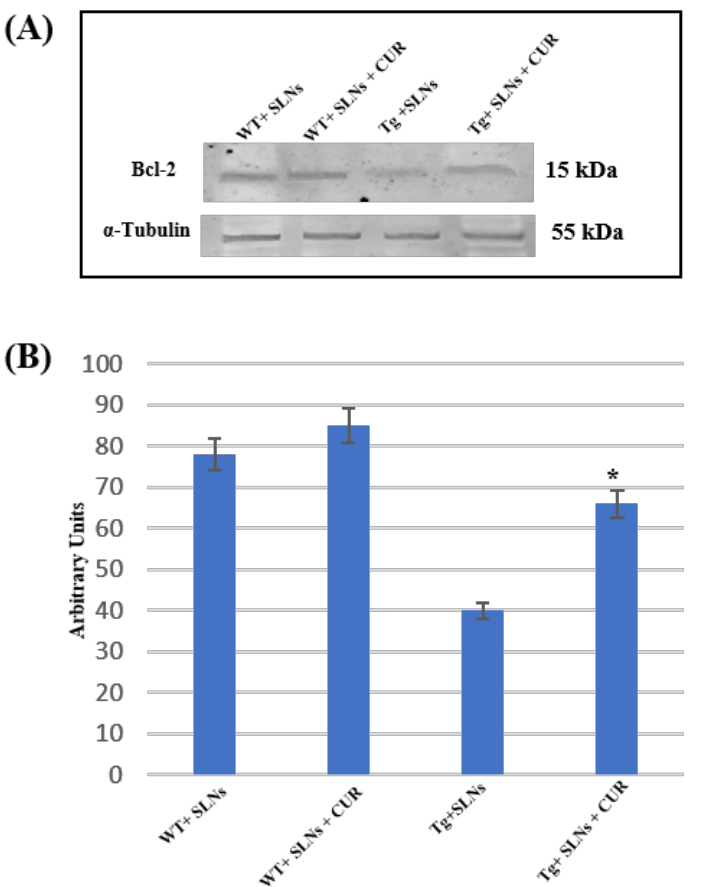
Figure 4. ( A ) Representative immunoblots analysis by Western blotting for Bcl-2 expression levels in total cellular lysate from WT-SLNs, WT-SLNs-CUR, Tg-SLNs, and Tg-SLNs-CUR mice systemically administrated for 3 weeks. ( B ). Bcl-2 expression densitometric analysis obtained after normalization with α -tubulin. The results are expressed as the mean ± S.D. of the values of five separate experiments performed in triplicate. * p < 0.05 Tg-SLNs-CUR vs. Tg-SLNs.